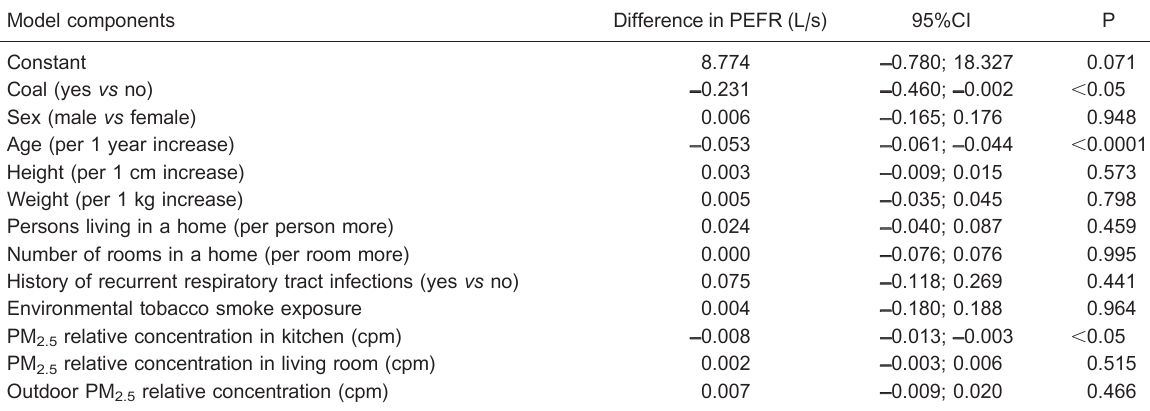
Table 5. Estimated parameters and 95% confidence interval (CI) of multivariate linear regression analysis of peak expiratory flow rate (PEFR; L/min). Model